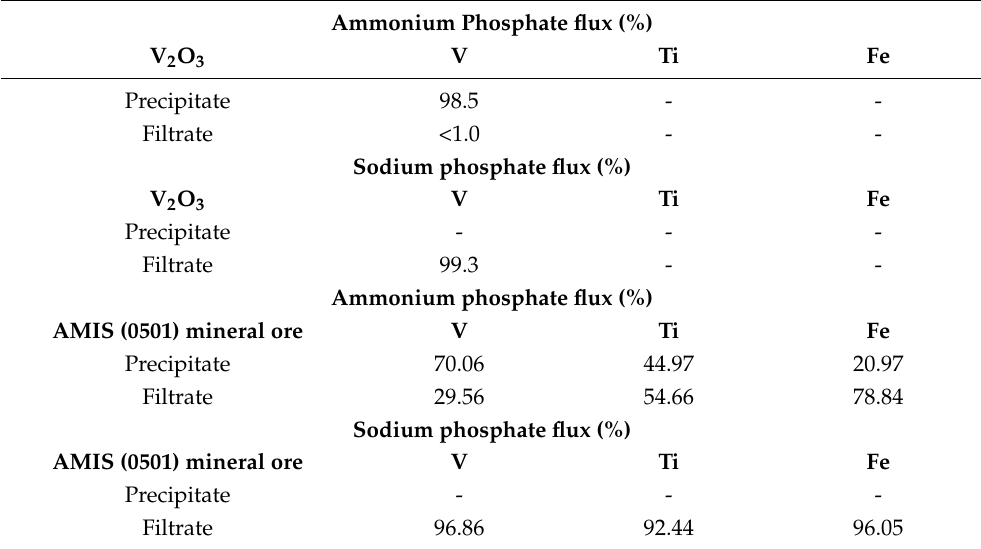
Table 5. Elemental content of the sample filtrate solutions obtained after fusion using ammonium and sodium phosphate